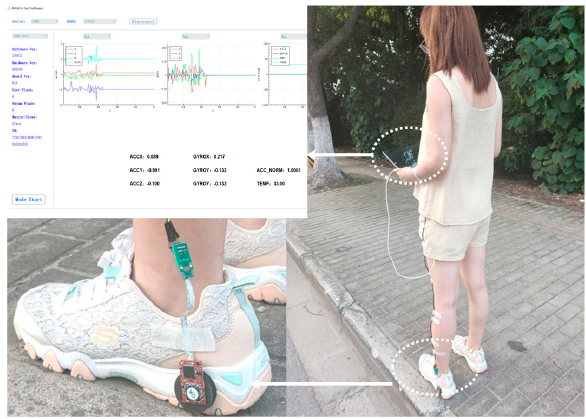
Figure 8. Straight line experiments scene based on foot-mounted IMU array.